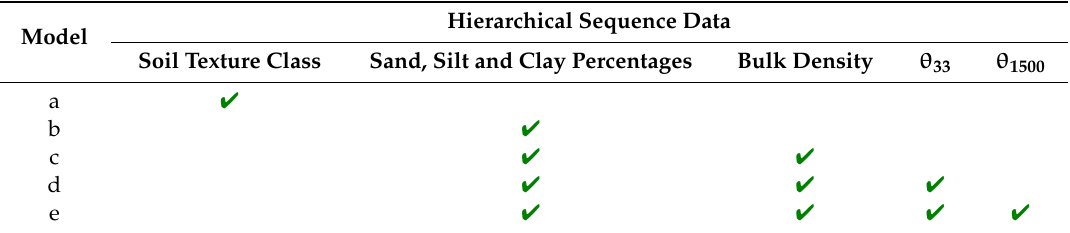
Table 3. Five hierarchical models of the Rosetta